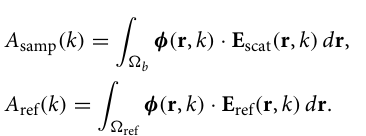
Figure 1. ( a ) A fiber-based Fourier domain OCT interferometer system. S ( k ) is the source spectral density. A ref ( k ) is the complex valued coupling coefficient of light reflected from sample arm. A samp ( k ) is the complex valued coupling coefficient of light reflected from sample arm. I det ( k ) is the detected intensity of the combined sample and reference arms of the interferometer. ( b ) Close-up geometry of the scattered field inverse problem. A plane wave travelling in the s 0 direction is incident on an object with scattering potential F ( r ) . The scattered field E r ) is measured on a plane normal to the z scat (